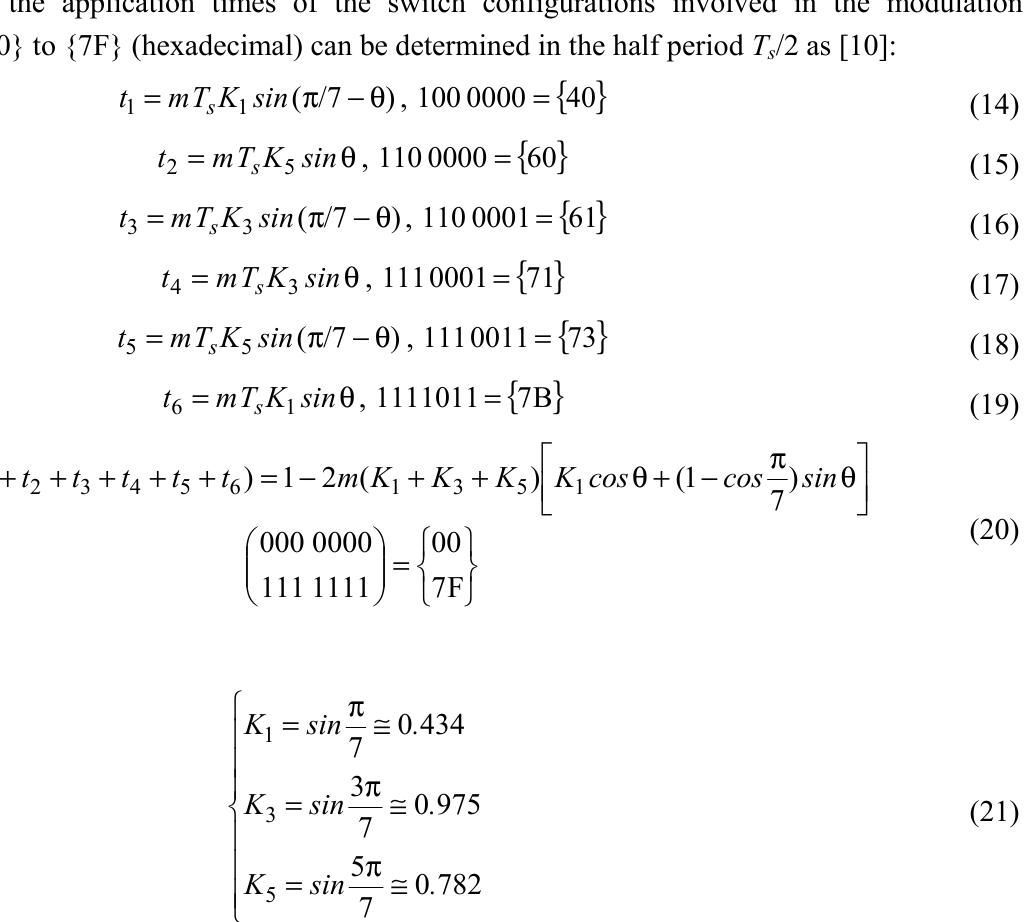
– β in the range 1 1 ≈ 0.513. Different colored areas max